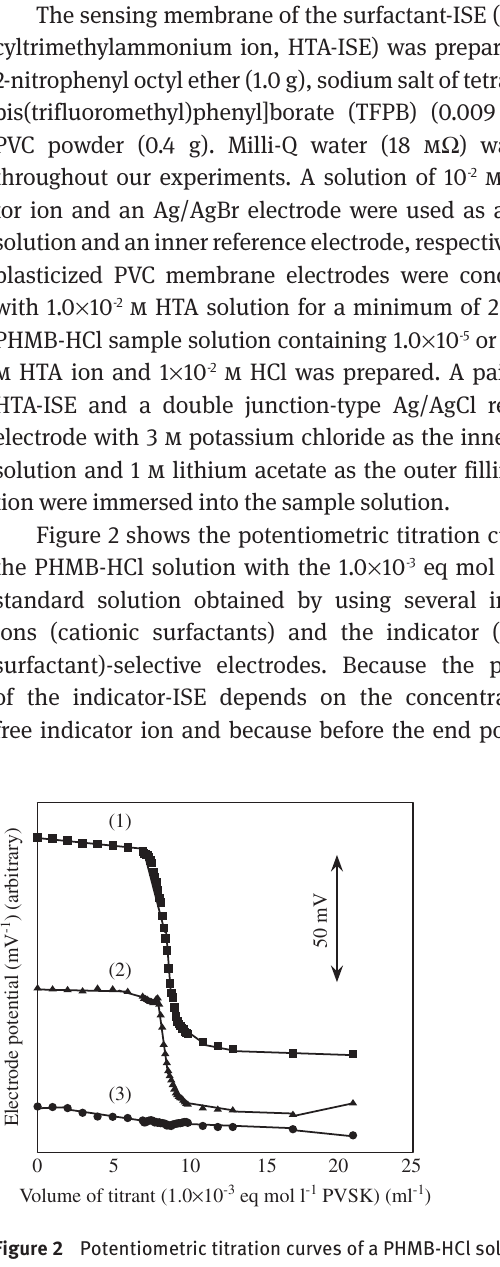
Figure 2 Potentiometric titration curves of a PHMB-HCl solution with a PVSK solution by using indicator ion-selective electrodes. Titrant: 1.0 × 10 -3 eq mol l -1 PVSK solution. Sample: 40.00 ml